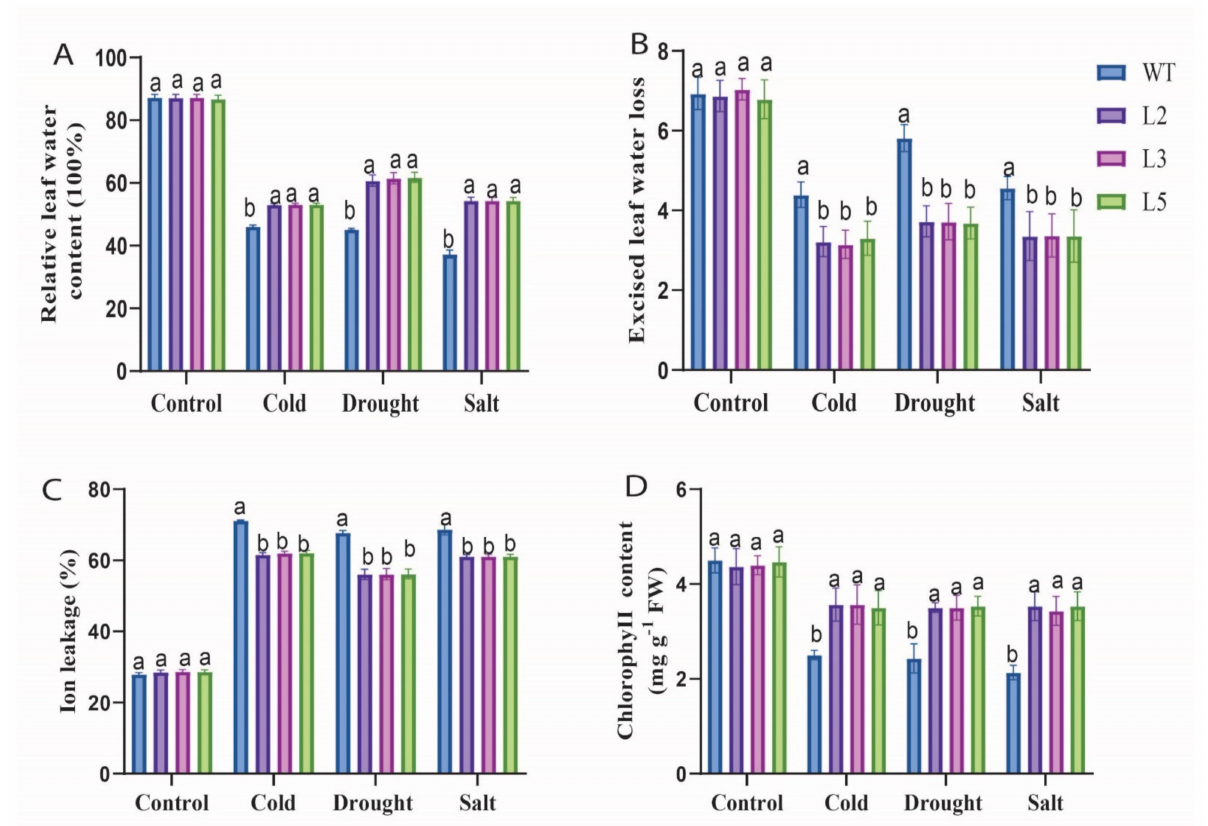
Figure 5. Assessment of physiological parameters in GhMPK3 over-expressed lines and WT under drought and salt stress conditions. ( A ) Relative leaf water content (RLWC), ( B ) Excised leaf water loss (EWL), ( C ) Ion leakage, and ( D ) Chlorophyll content after 8 days of exposure to stress. Each experiment was performed three times. The bar represents a standard error (SE). Various letters above the columns indicate statistically significant differences (ANOVA, p < 0.05). WT: Wild type. L2, L3, L5: Overexpressed